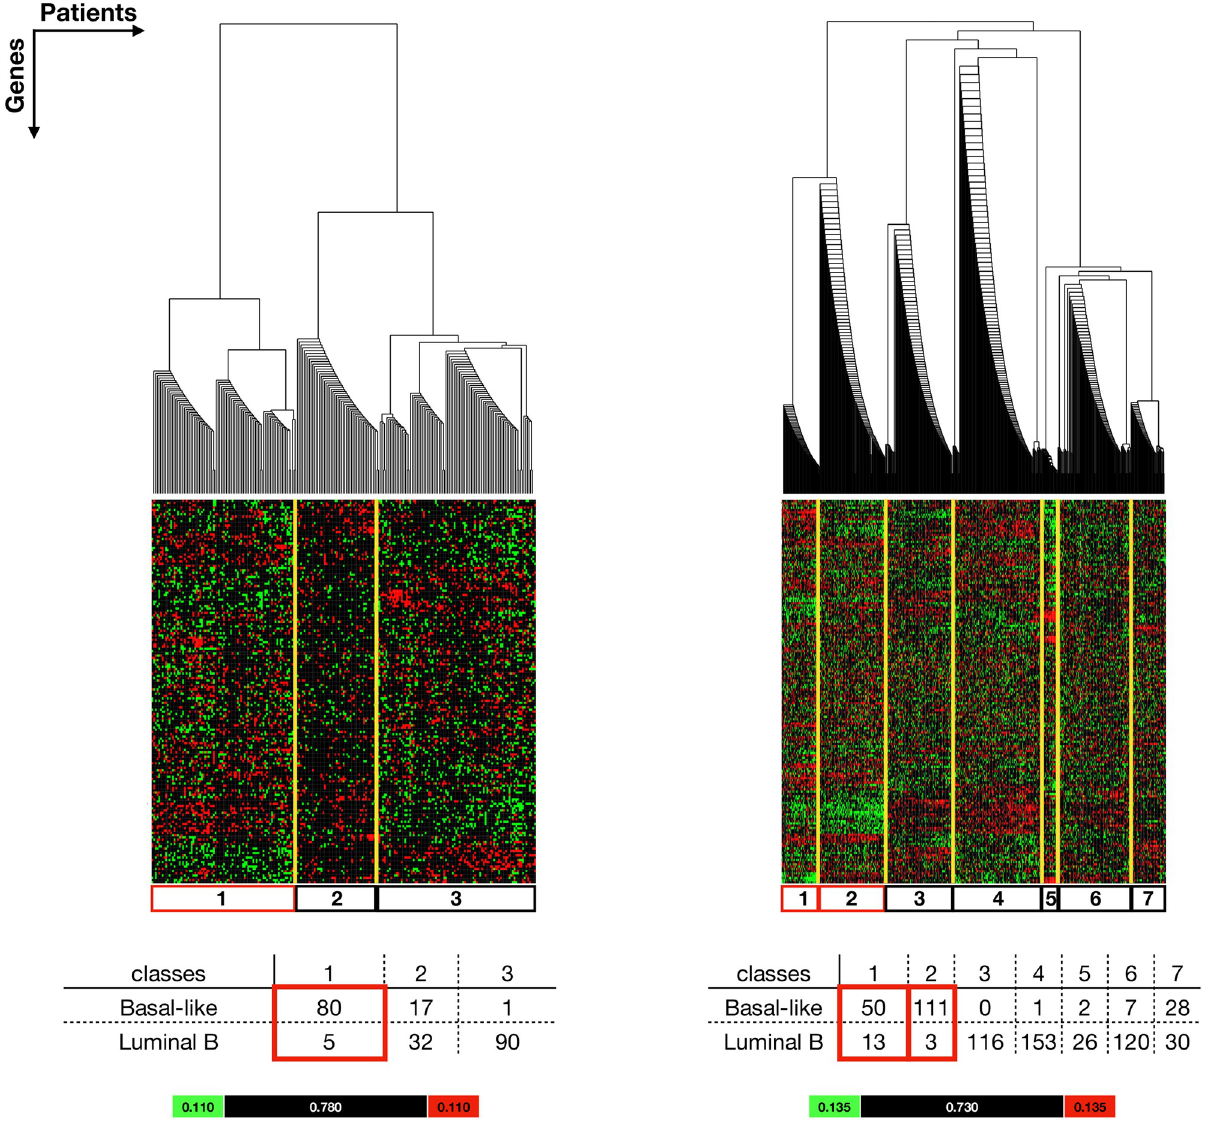
Fig 3. Extracted results from Basal-like vs Luminal B comparison show a natural stratification of Basal-like vs Luminal B patients (columns) according to the NR-associated gene expression signals (rows). See S3.4 and S3.5 Files in S3 Appendix for the complete results. Left: Patients from TCGA dataset were grouped into 3 classes. Class 1 is considered as a Basal dominant class . Right: Patients from METABRIC dataset were grouped into 7 classes in which class 1 and class 2 are considered as Basal dominant classes . Yellow lines highlight the classes (simplified from the clusters) and the corresponding expression pattern in the colour plots. The tables show the number of Basal-like and Luminal B patients in each class. The Basal dominant classes are highlighted in red boxes in the table and colour plots. The colour bar indicates the lowerbound (green), likelihood (black) and upperbound (red).